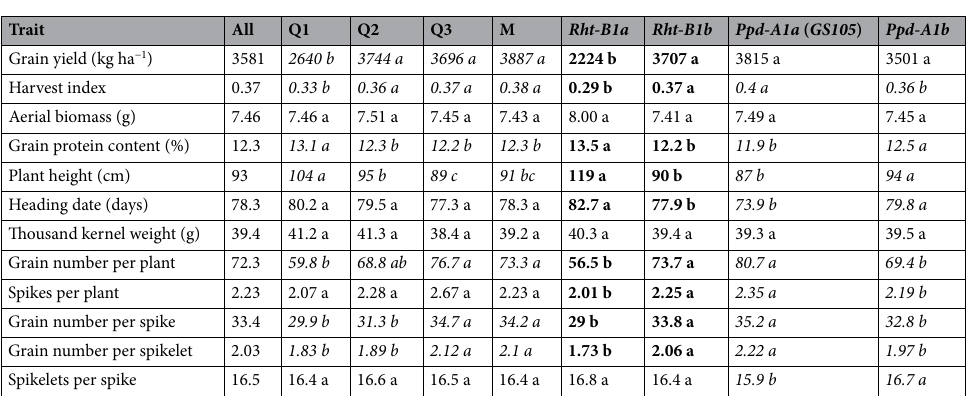
Table 5. LSMeans for 12 agronomic traits considering the STRU CTU RE groups and the allelic variants at the Rht-B1 and Ppd-A1 loci in three environments. Different letters indicate significant differences at P < 0.05 according to Tukey’s test. Significant values are in bold and